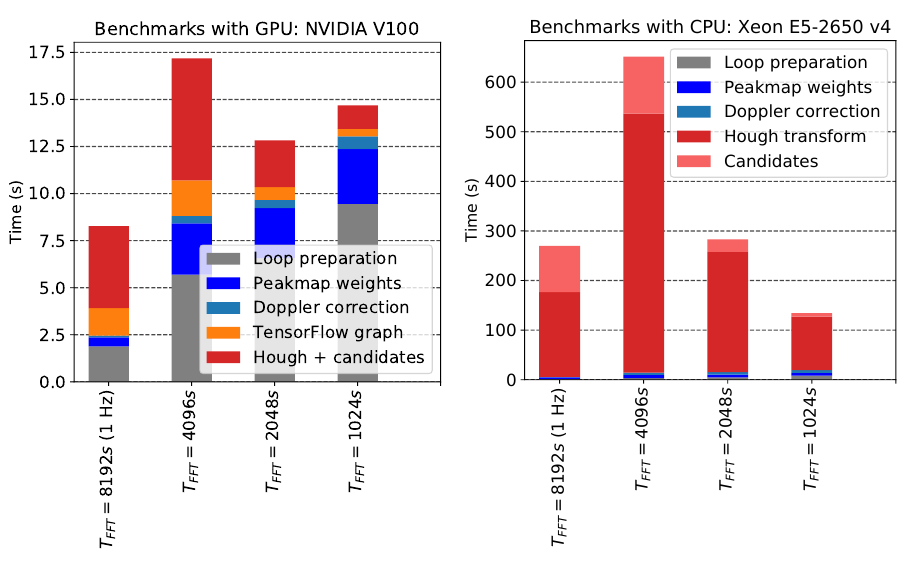
Figure 6. Detailed comparison between the estimated running time of the GPU- ( left plot ) and the CPU- ( right plot ) based FrequencyHough codes. The grey part of the benchmark is executed only once per job and contributes negligibly to the overall cost, while the colored parts of the bars constitute one iteration over the sky positions and are in the main loop. The part where TensorFlow is involved has been split into two pieces: the graph building and variables initialization (orange) and the graph execution (red). The GPU code, after the TensorFlow graph is created, computes the FrequencyHough transform and the candidate selection at once, so it is not possible to split the two steps without the introduction of an overhead caused by the fact that the graph is generated and run in two steps. We remark that the CPU code can run only on a single thread. Hence, in the right plot we show the performance in terms of computing times using a single CPU